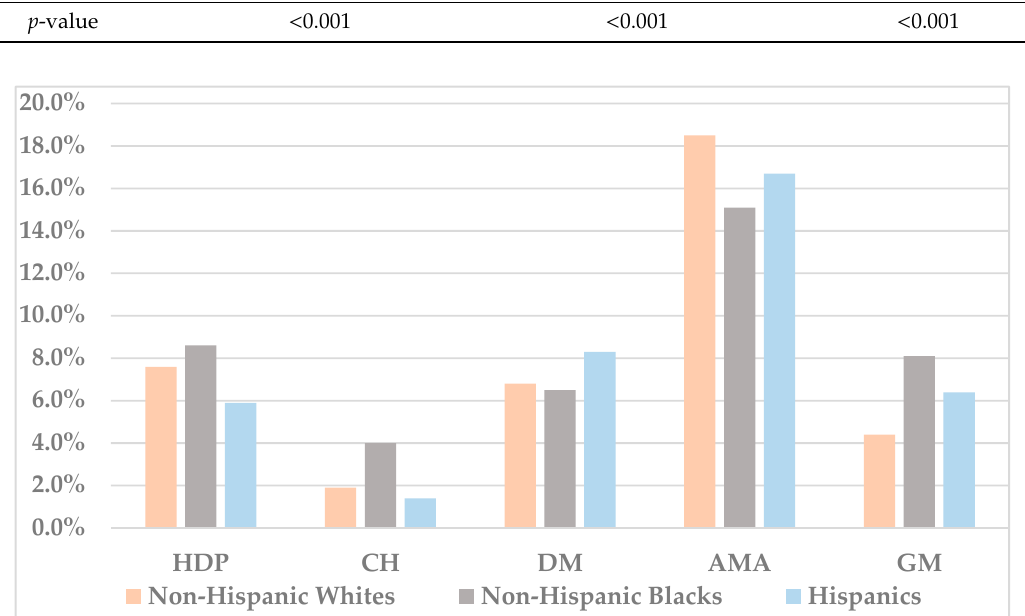
Figure 1. The prevalence of the pregnancy risk factors/complications in 2018, by racial/ethnic group. All of the differences between the racial/ethnic groups are statistically significant ( p < 0.001).